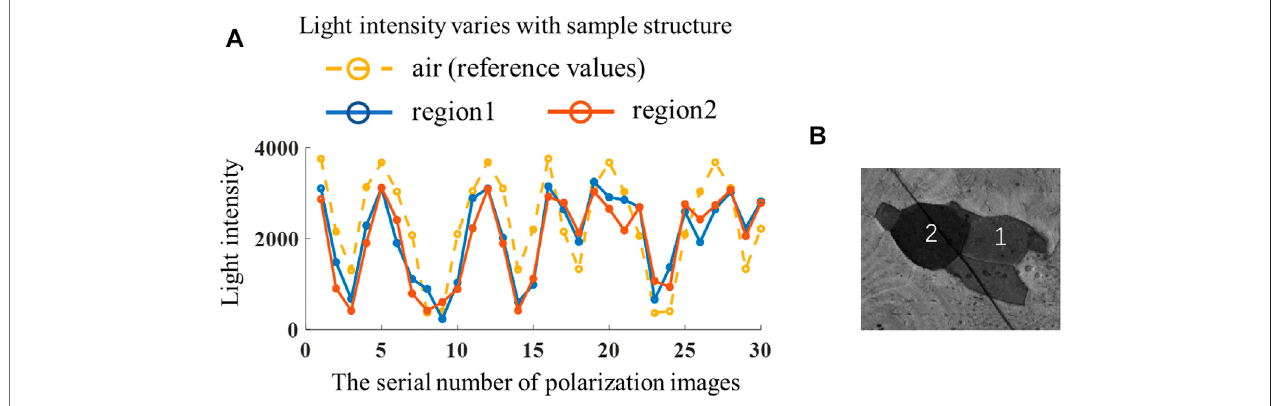
FIGURE7| Comparison oftheresolutionboardbetweentwosystems: (A) normalizedlightintensityforthewide- fi eld; (B) normalizedlightintensityforthe fl at- fi eld; (C) Δ of wide- fi eld; (D) the Δ of fl at- fi eld; (E) distribution of the normalized light intensity in two systems; (F) variation of light intensity with distance; (G) distribution of Δ in two systems; (H) variation of Δ with distance.